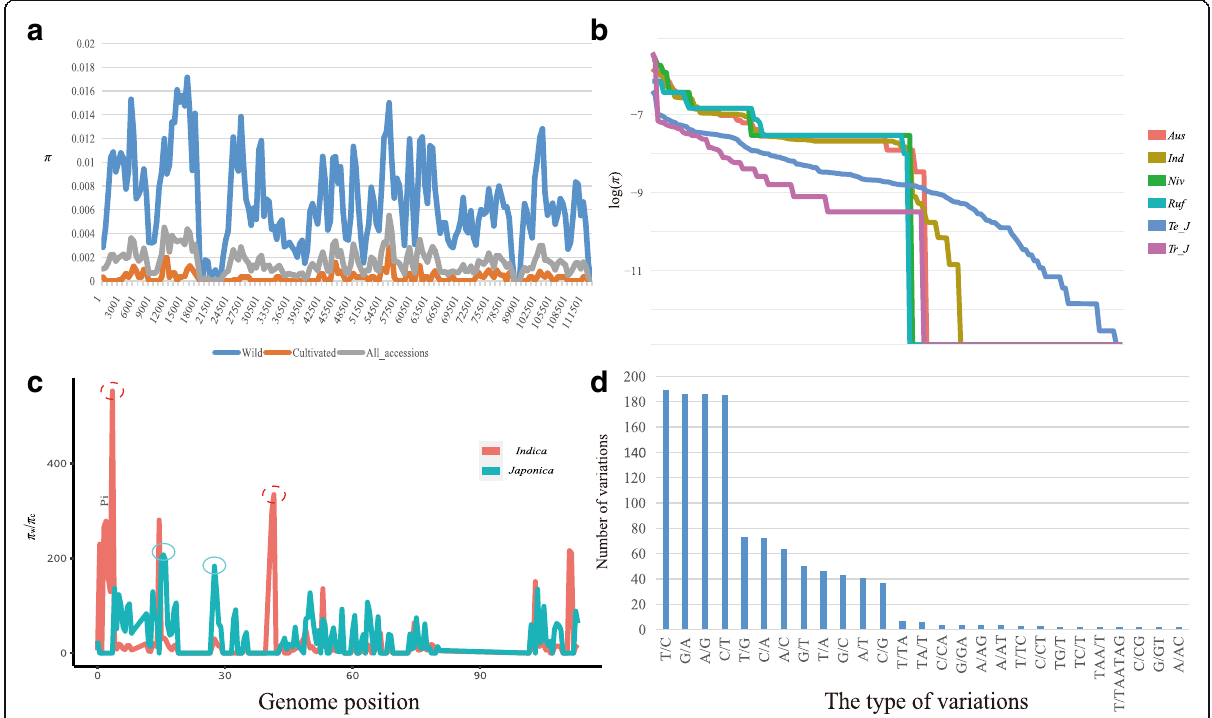
Fig. 5 Nucleotide diversity and variant type of all accessions and subgroups. ( a ) Nucleotide diversity of whole collection, Asian rice, and wild rice. The 500 bp window size was used in this analysis. ( b ) Nucleotide diversity of subgroups. The sorted values were plotted in each group. Ind: indica ; Niv: O. nivara; Ruf: O. rufipogon ; Te_J; temperate japonica ; Tr_J; tropical japonica . ( c ) Reduction of nucleotide diversity ( π w / π c ) between indica and japonica in the cp genome. The threshold of top 2.5 percentile is indicated as a red dotted circle for indica , blue circle for japonica . The regions within the 2.5 percentile are considered as candidate regions under selection. The number of genome position unit is kb. ( d ) Summary of variant types among the cp